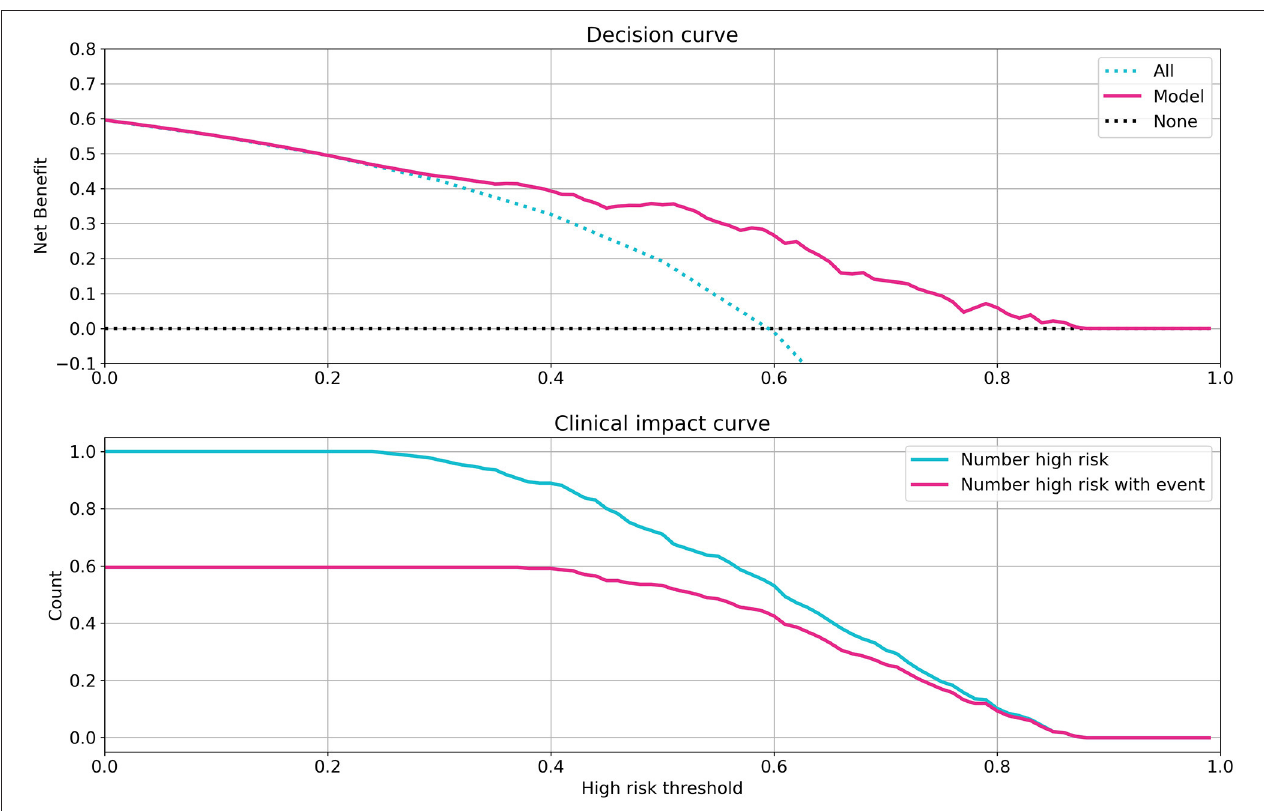
FIGURE 4 | Investigation of clinical impacts and benefits of the model. Decision curve (Top) and clinical impact curve (Bottom) of the random forest model. The decision curve compares the net benefits of an intervention in three scenarios: intervention for all patients (blue dotted line), intervention for no patients (gray dotted line), and intervention for high-risk patients based on the model prediction (red line). The clinical impact curve compares the number of patients classified as high risk by model and the number of patients with a really poor bad outcome who were classified as high risk, for all possible high-risk thresholds in model prediction from 0 to